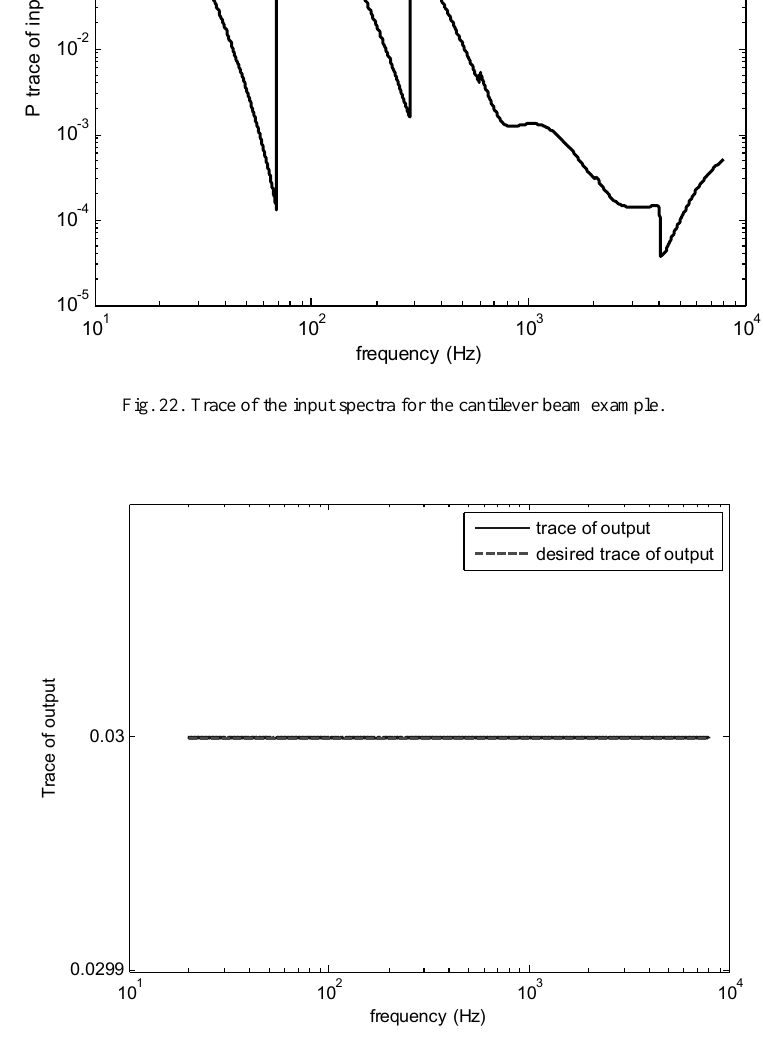
Fig. 23. Trace of the output spectra for the cantilever beam